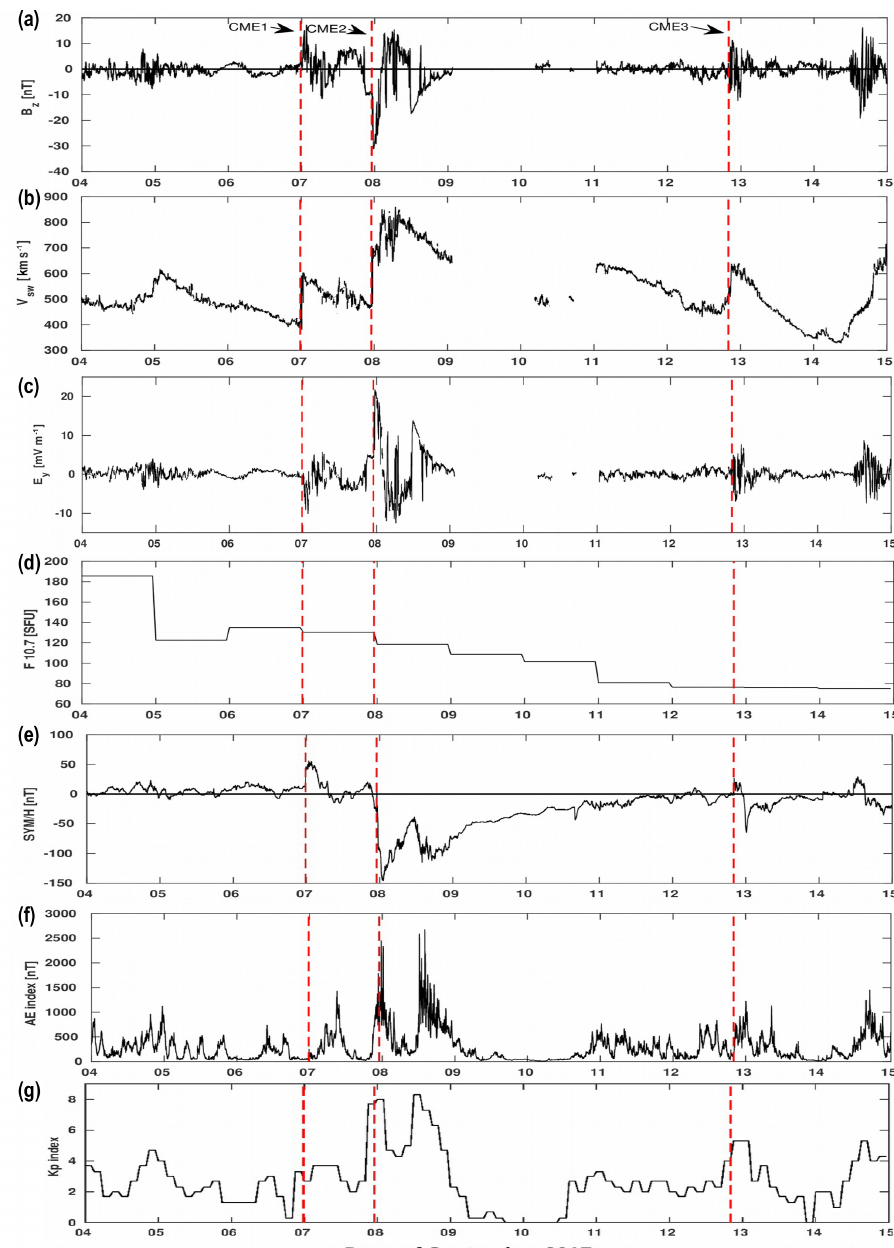
Figure 1. Solar wind parameters and geomagnetic indices characterizing the geomagnetic storm during 4–14 September 2017. From (a) to (f) : B z component of the magnetic field, solar wind velocity V sw (in kms − 1 ), E y component of the interplanetary electric field, F 10 . 7 , SYM-H index and AE index. Panel (g) illustrates the Kp